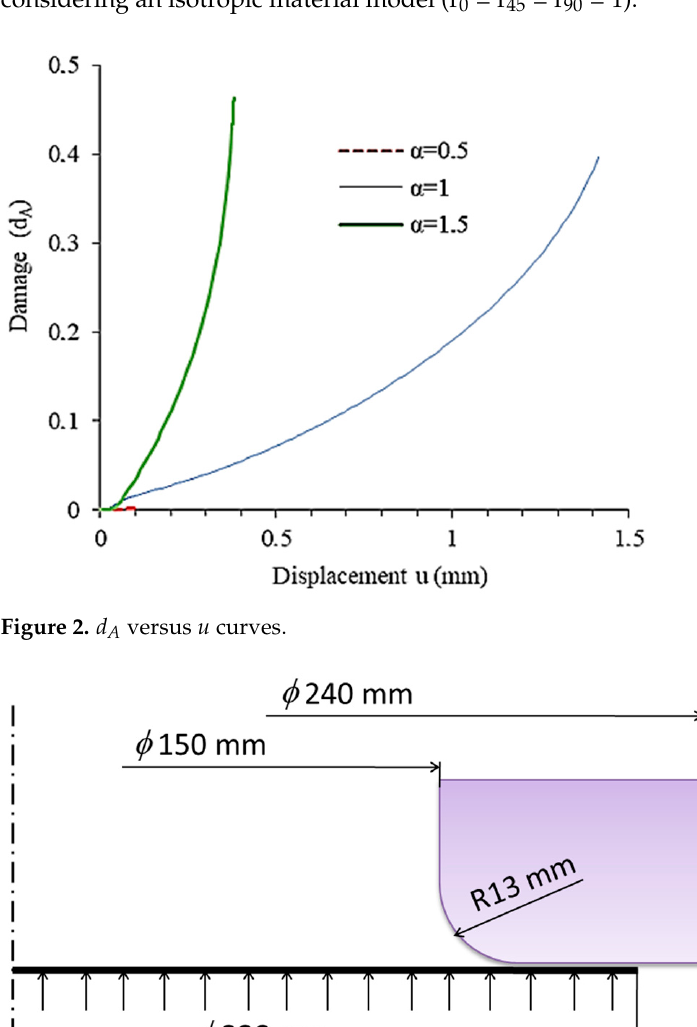
Figure 3. Geometry tool of the bulge test. Table 4. Material properties considered in bulge